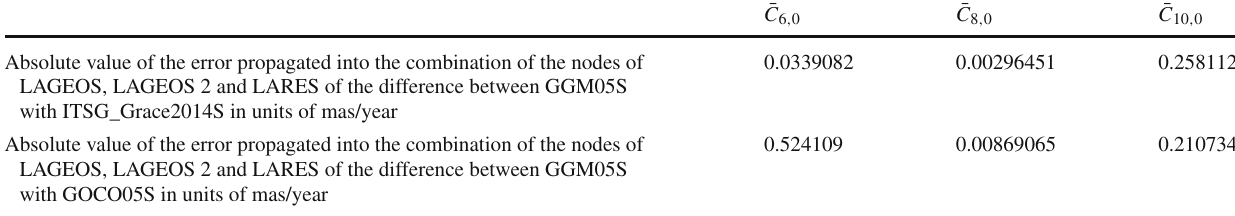
Table 2 Error propagated into the node of LAGEOS, LAGEOS 2 and LARES due the differences between GGM05S and ITSG_Grace2014S and GOCO05s for each coefficient ¯ C 6 , 0 , ¯ C 8 , 0 and ¯ C 10 , 0